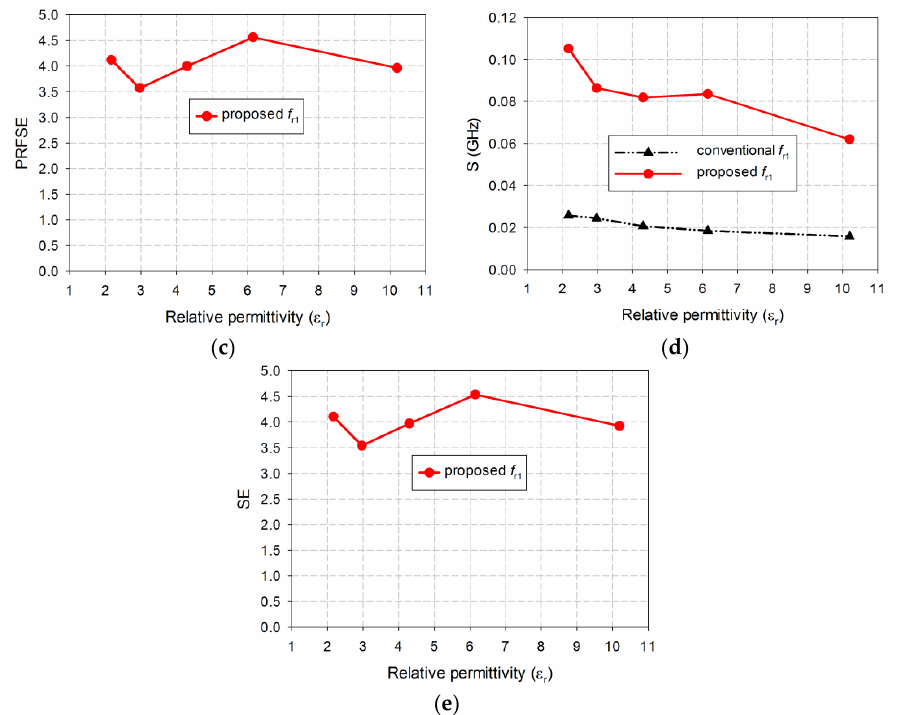
Figure 14. Measured sensitivity comparison of the conventional and proposed patch antennas for the MUTs in Table 2: ( a ) Δ f r ; ( b ) PRFS; ( c ) PRFSE; ( d ) S; ( e ) SE.